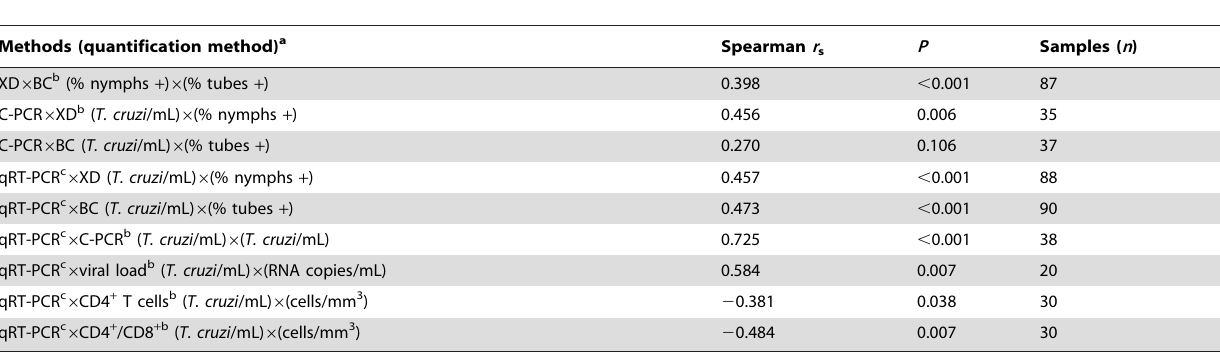
Table 3. Spearman’s rank correlation coefficients observed between tests: blood culture, xenodiagnosis, competitive PCR, quantitative real-time PCR.